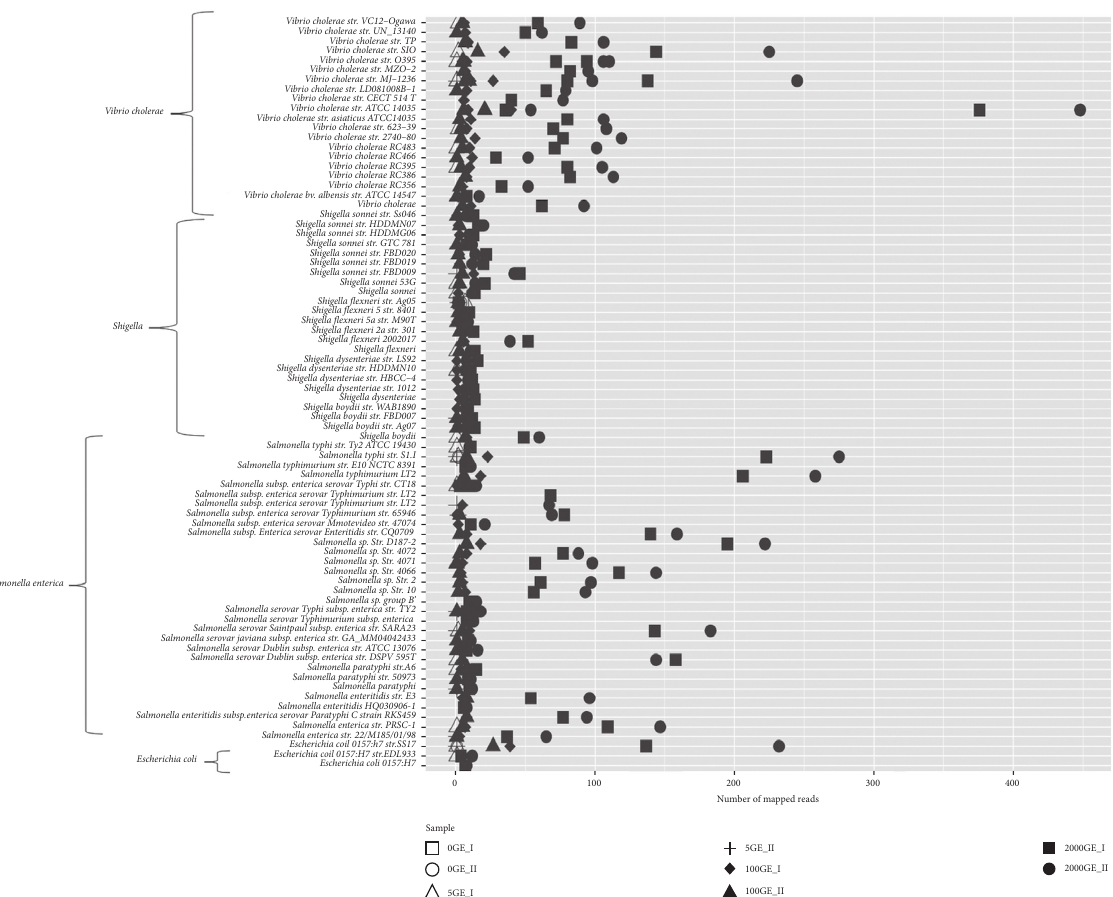
Figure 3: Top reads of the simulated bacterial DNA mock community ( S . enterica , V . cholerae , and E . coli) in human DNA background sequenced in Ion Torrent PGM platform mapped according 364 target sequences. Shigella mapping is also included. Different GE concentrations are in duplicate. OGE_I and II; 5GE_I and II; 100GE_I and II; 2,000GE_I and